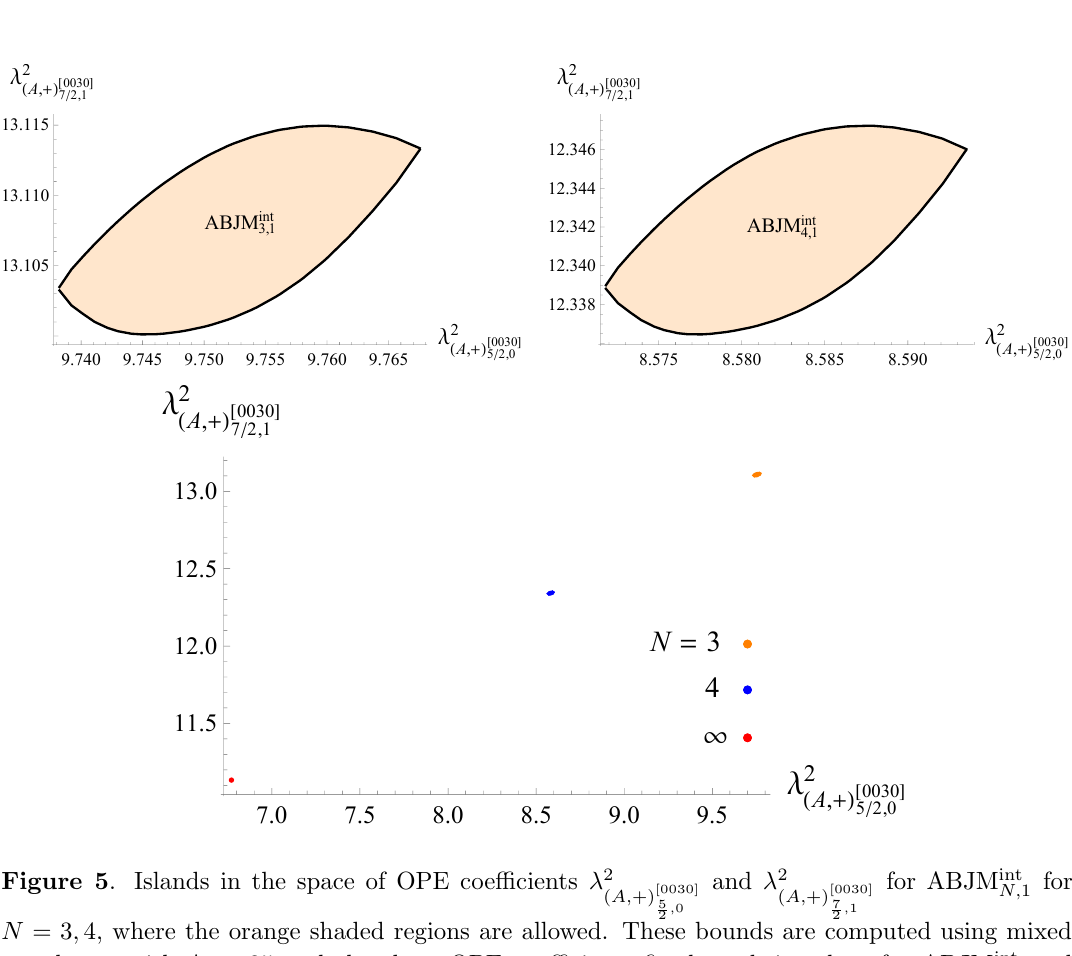
and (cid:21) 2 for ABJM int for N; 1 ( A; +) [0030] 5 ( A; +) [0030] 7 2 ; 0 2 ; 1 and 3 ; 1